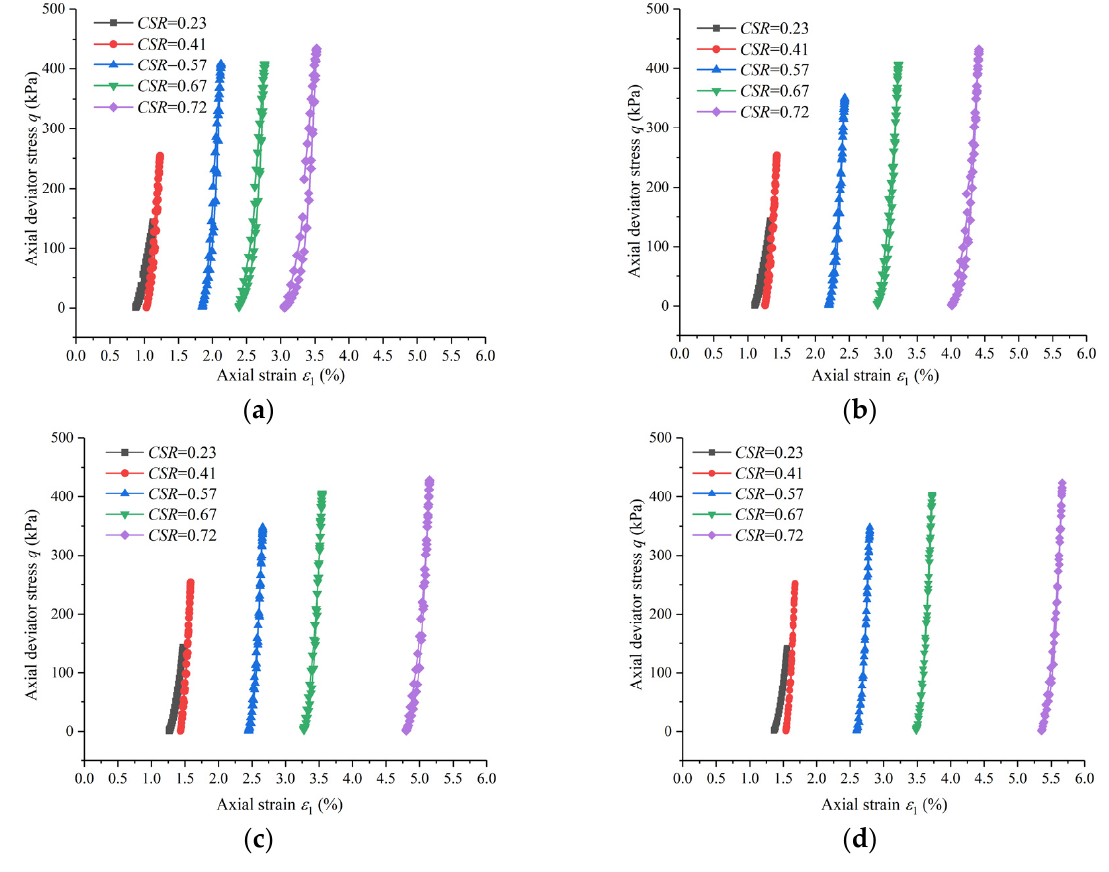
Figure 11. Stress–strain hysteresis loops under a confining pressure of 60 kPa after different numbers of loading cycles: ( a ) Number of loading cycles N = 10; ( b ) Number of loading cycles N = 100; ( c ) Number of loading cycles N = 1000; ( d ) Number of loading cycles N = 10,000.